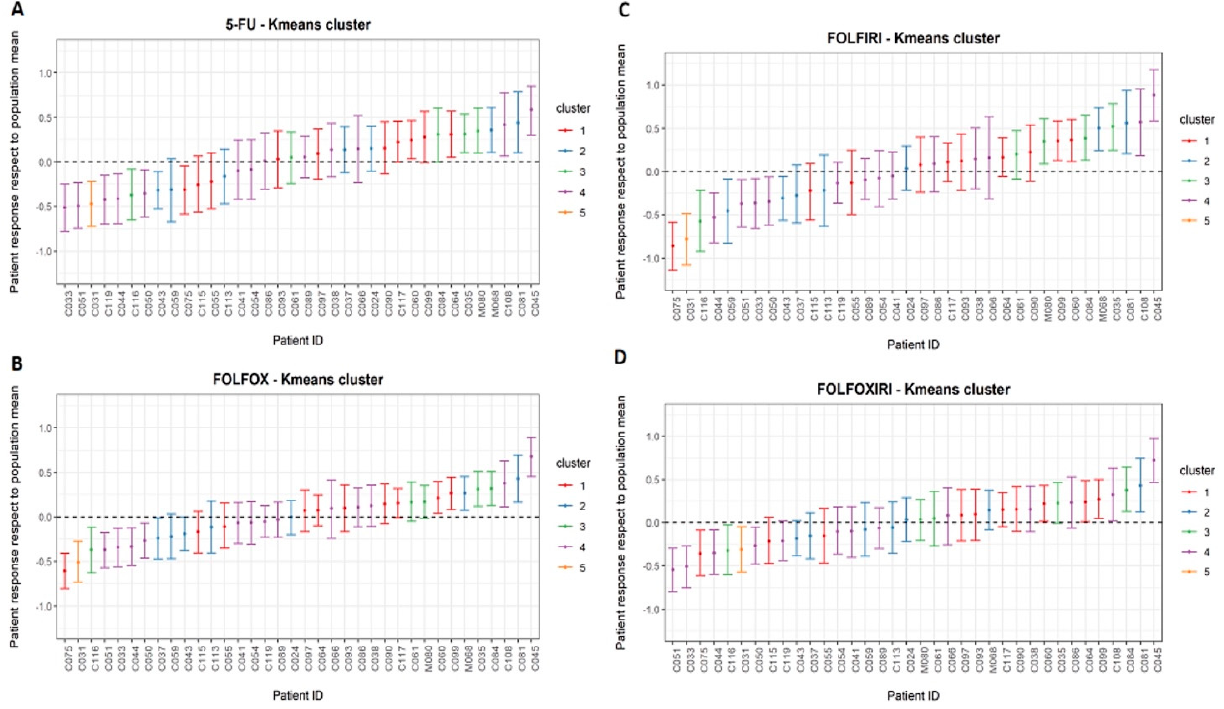
Figure 4. Error bars represented 95% confidence interval of the % ∆ V for 5-FU ( A ), FOLFOX ( B ), FOLFIRI ( C ), and FOLFOXIRI ( D ) resulted from k-means clustering. The graphs displayed how patients within each chemotherapy treatment were assigned in one of the five cluster groups. The different colors identified different clusters.